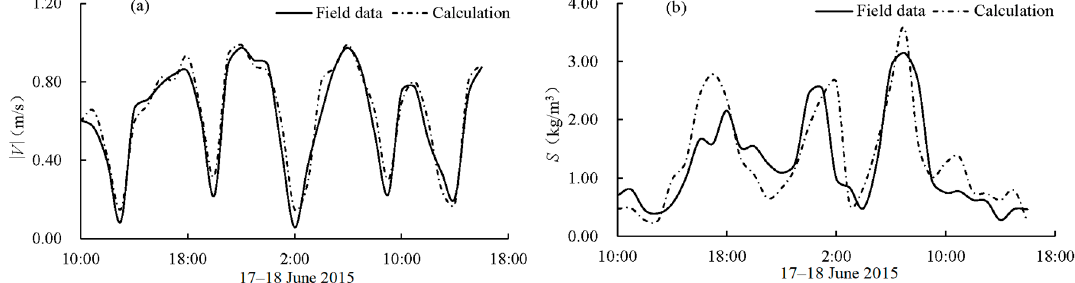
Figure 10. Model calibration, numerical vs. field results at FS3 (spring tide, June 2015): ( a ) |𝑉| ; ( b ) S .